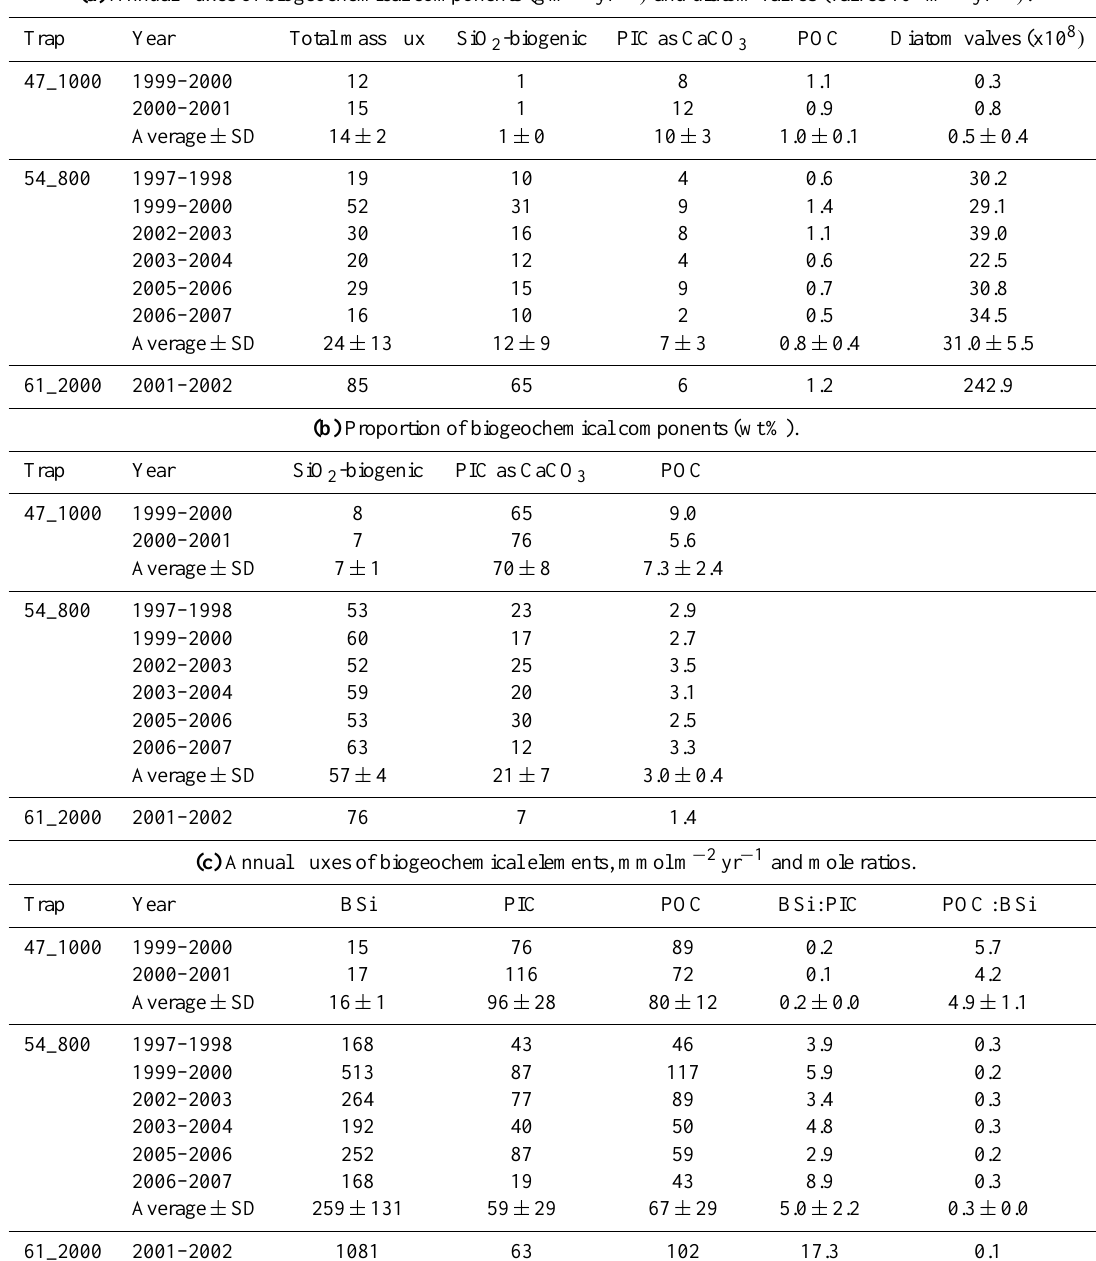
Table 3. Estimated annual export fluxes of total mass flux, biogenic silica, calcium carbonate, POC and diatom valves for <1mm fraction at the 47, 54 and 61 ◦ S